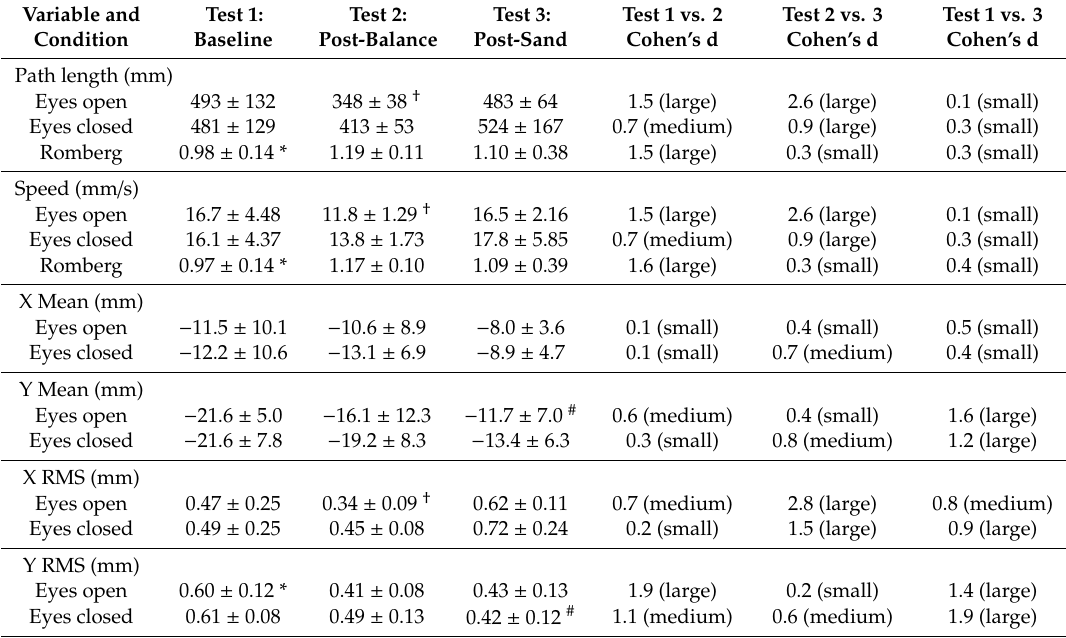
Table 1. Bipedal stance. Parameters expressed as mean ±